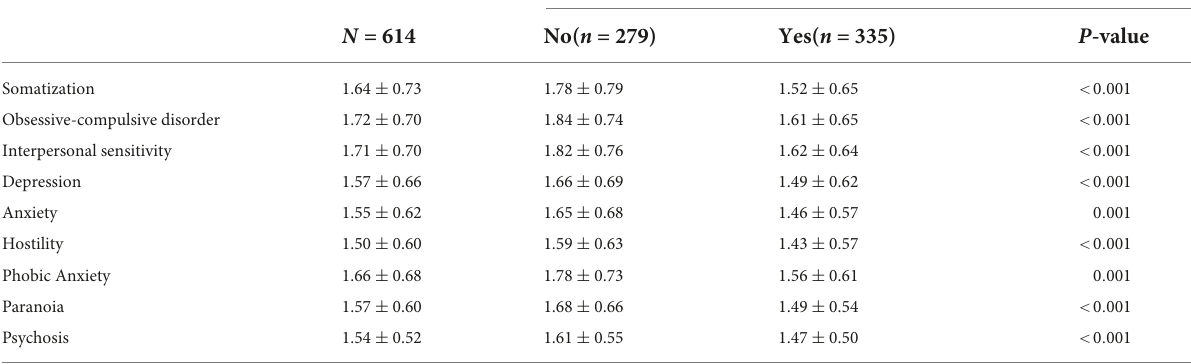
TABLE 3 Scores of subscales of SCL-90.